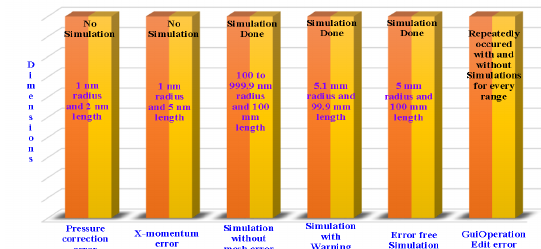
Fig. 11: Graphical summary of simulation for straight crossed